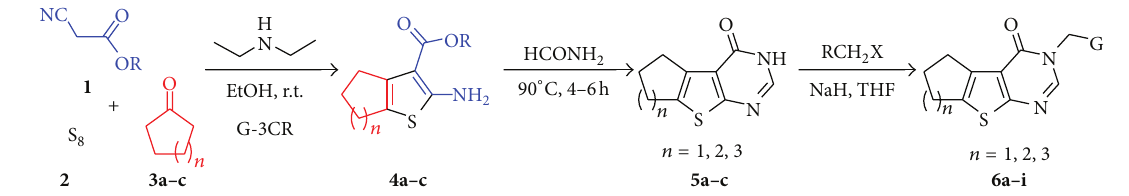
Scheme 1: General synthetic route for target compounds 6a–i